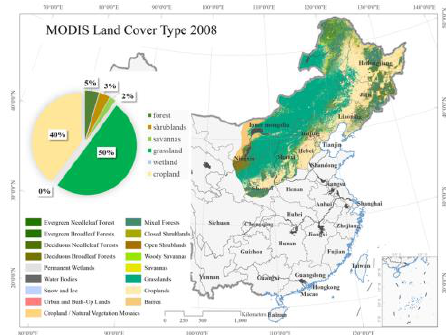
Figure 4. Land Cover Type in Drought